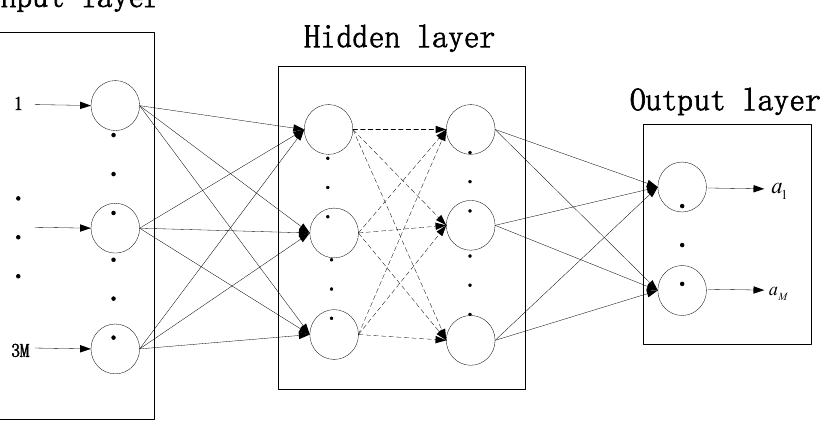
Figure 4. SAE network topology.